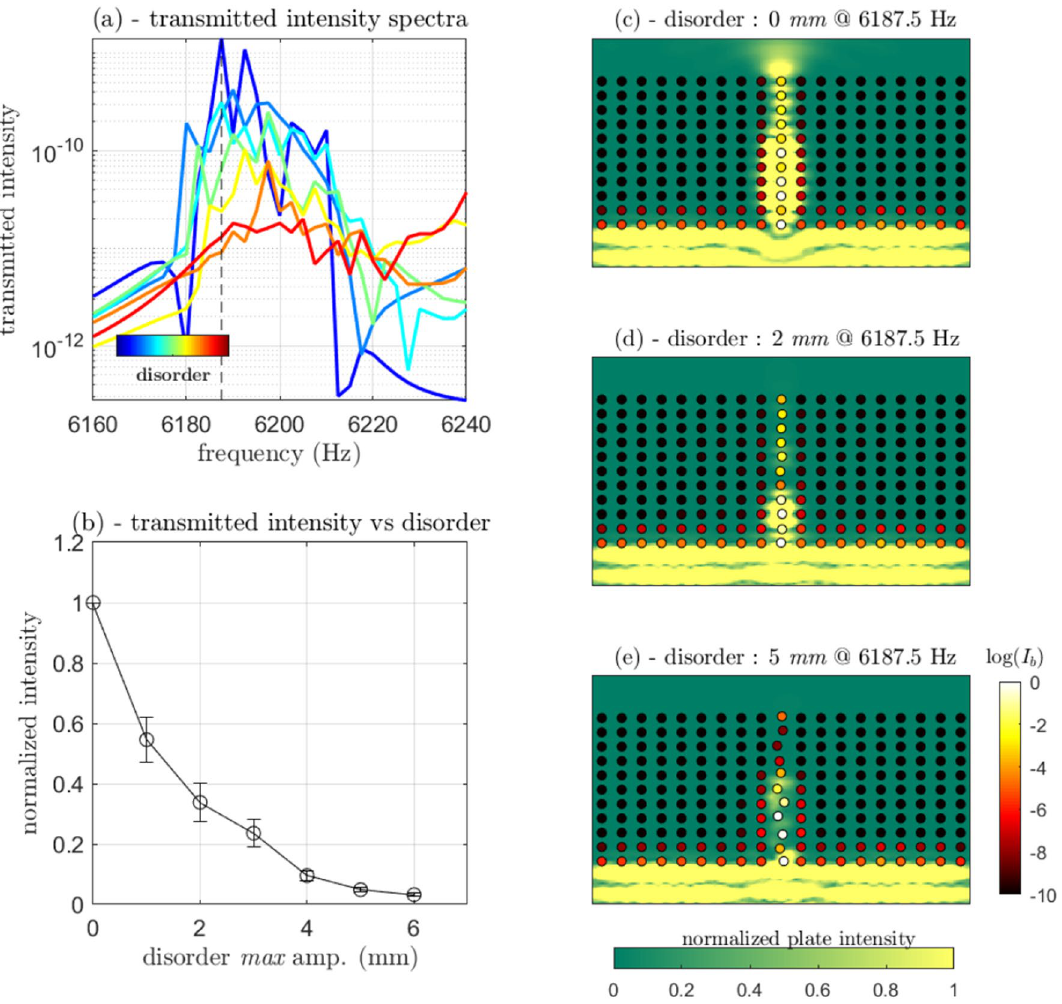
Figure 5. Effects of the randomness of the central line beam positions on the transmission intensity. ( a ) Mean transmission spectra for the 5.3-mm-diameter beams in the central line and the different values of the disorder. ( b ) Normalized transmitted intensity versus amplitude of the disorder, as indicated. ( c ) same as Fig. 2b at 6195 Hz. ( d , e ) Intensity map at 6195 Hz for 2 mm and 5 mm random displacements of the beams in the central line. The intensity maps are normalized by the maximum transmitted intensity for the case without disorder. ( c – e ) The beam motion amplitude is depicted as a ‘log’